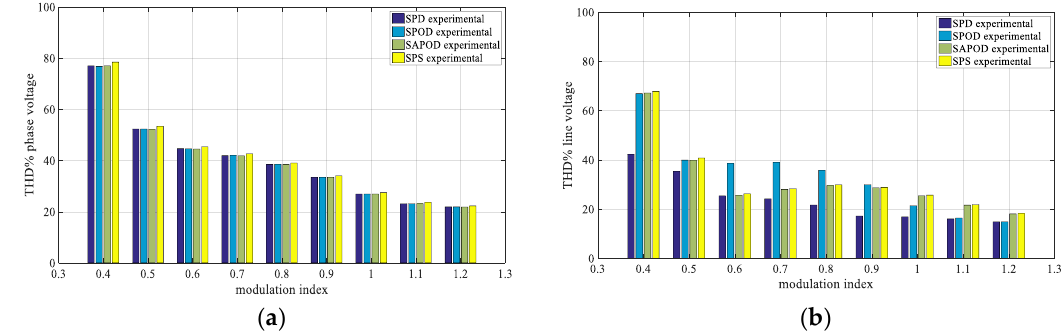
Figure 10. Comparison between the experimental THD% results for ( a ) phase voltage and ( b ) line voltage.